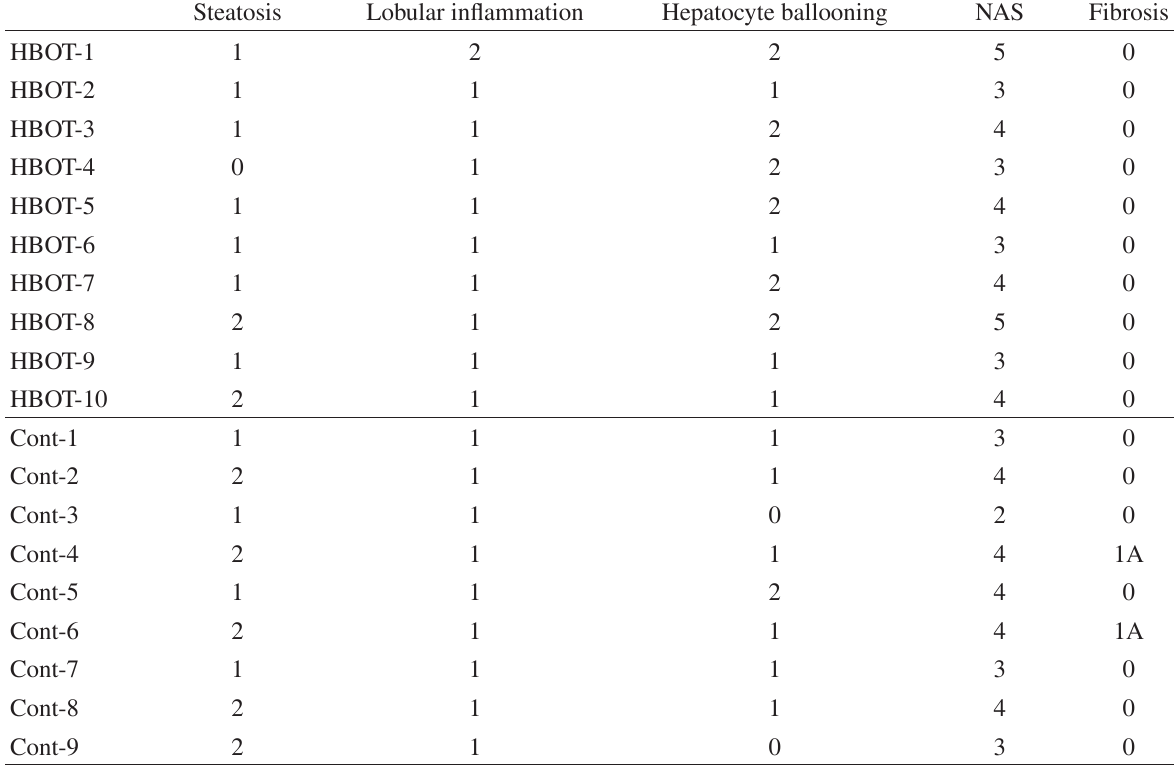
TABLE 2: NAS score and